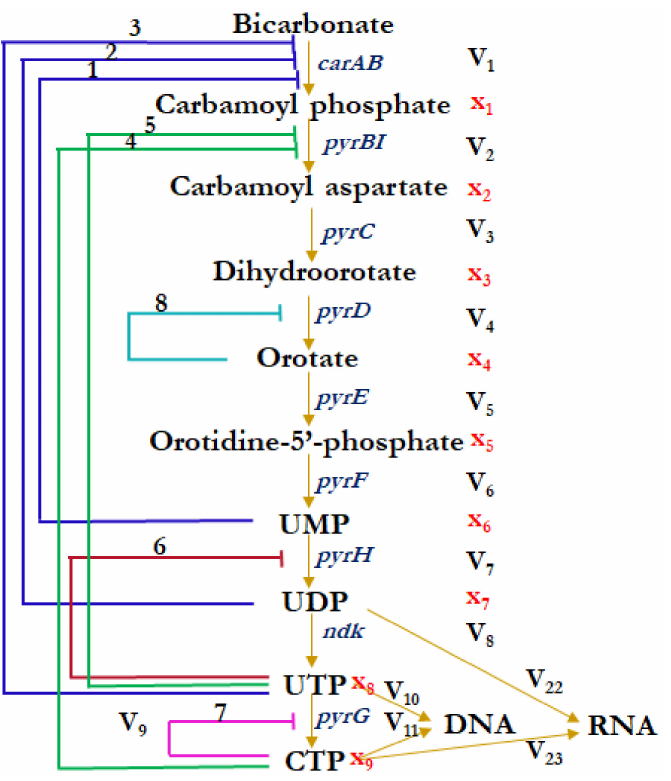
Figure 1. A scheme of the regulation of the metabolic pathway of de novo pyrimidine nucleotide biosynthesis in E. coli . Arrows represent the direction of enzymatic reactions; lines ending at the blunt end indicate loops of negative regulation of enzyme activity by biosynthetic products. The blue color of the regulatory loops reflects the regulation of the first enzymatic reaction controlled by carbamoyl-phosphate synthetase (EC 6.3.5.5); green represents the second, aspartate transcarbamoy- lase (EC 2. 1.3.2); sea wave—fourth, dihydroorotate dehydrogenase (EC 1.3.5.2); red—seventh, UMP kinase (EC 2.7.4.14, 2.7.4.22); and pink—ninth, CTP synthetase (EC 6.3.4.2). The numbers above the negative feedbacks denote the sequence number of the regulatory relationship in the model analysis— the considered stages of pyrimidine nucleotide biosynthesis are controlled by 8 regulatory loops. V j (j = 1, . . . ,9)—rates of enzymatic reactions; V 10 , V 11 , V 22 , V 23 —outflow rates; X j (j = 1, . . . ,9)— model variables—concentrations of substances. Full names are given for the first six substances, and generally accepted abbreviations are given for the